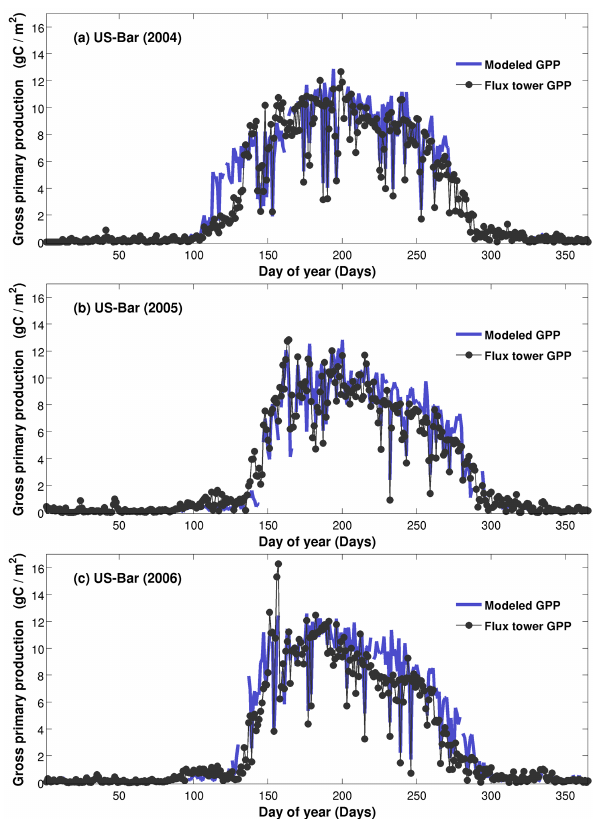
Figure 9. Time series of modeled and measured daily GPP shown for (a) 2004, (b) 2005, and (c) 2006 at the US-Bar site. Model sim- ulation is performed at a half-hourly time step. Measured and mod- eled half-hourly GPP are aggregated to generate daily time series with units converted from µmolCO 2 m − 2 s − 1 to gCm − 2 day − 1 . Occasional negative GPP measurements are set to zeros. Missing points in modeled GPP time series are due to missing measurements of meteorological variables during the daytime photosynthetically